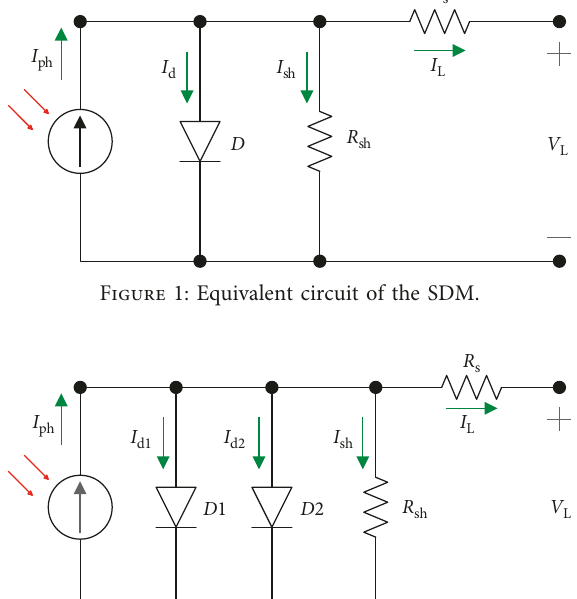
Figure 2: Equivalent circuit of the